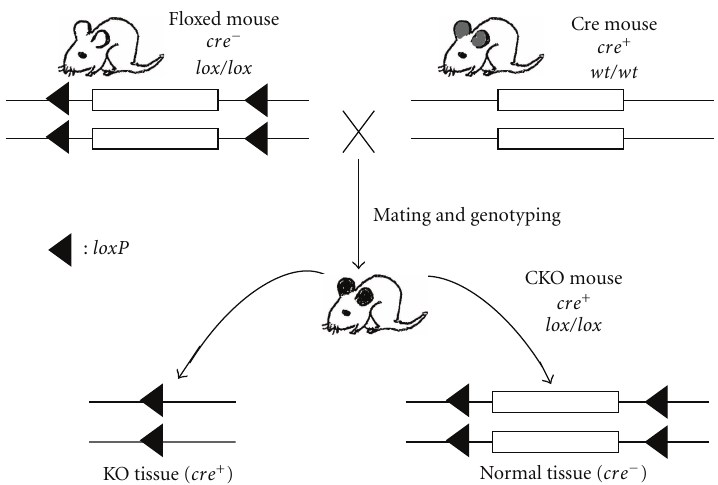
Figure 1: Schematic diagram of generating a conditional knockout (CKO) mouse from breeding a tissue-specific Cre mouse (top right) with a mouse carrying homozygous floxed gene (top left). A CKO mouse carrying a homozygous floxed gene and cre (either heterozygous or homozygous) is obtained by genotyping the F2 o ff spring. Tissue-specific Cre expression is shown as grey-eared (top right). Tissue-specific gene KO is diagramed as black-eared